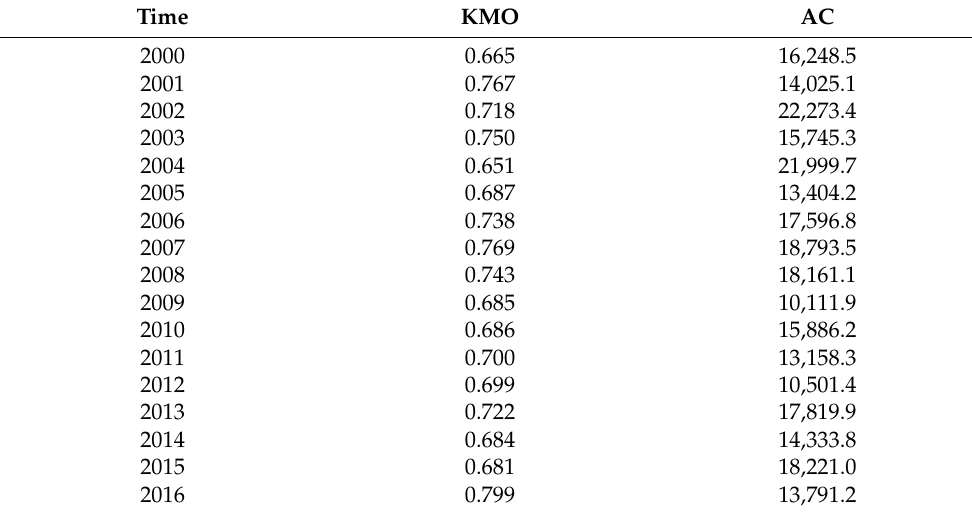
Table 2. Results of the factor analysis adaptation test.